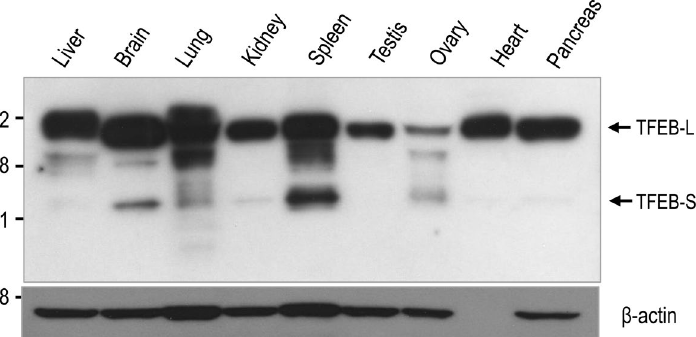
Figure 2. A small TFEB protein is produced in various human tissues. The expression level of TFEB and actin proteins was examined by immunoblotting using anti-TFEB and anti-actin antibodies, respectively. Full blots are provided in Supplementary Fig. S6.